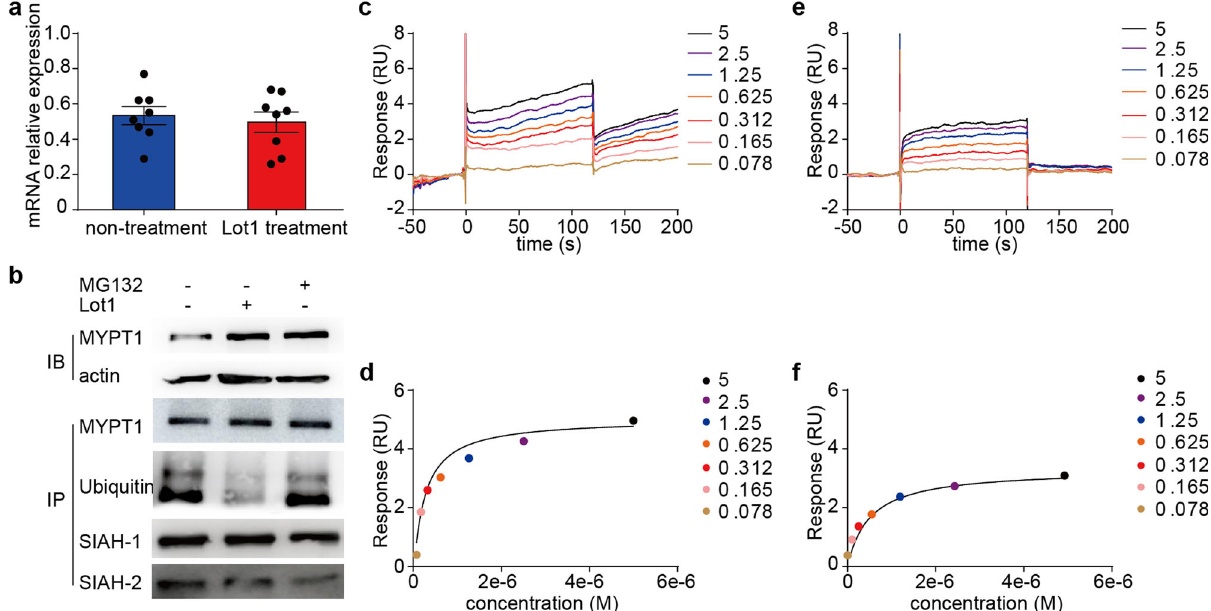
Fig. 8 Lotusine upregulated MYPT1 expression by inhibiting MYPT1 ubiquitination by binding SIAH1/2. a Mypt1 mRNA levels in A7R5 cells treated with or without lotusine were unchanged, as measured by Q-PCR ( n = 8). b , A7R5 cells were treated with MG132 (20 μ m, 4 h) and lotusine (0.5 μ m, 24 h), and the lysates were subjected to immunoprecipitation (IP) with an anti-MYPT1 antibody and immunoblotting (IB) for ubiquitinated MYPT1, SIAH2 and SIAH2 ( n = 3) in the immunoprecipitate. c-e, Representative binding sensorgrams showing the kinetics of Lot1 binding to SIAH1-GST ( c ) and SIAH2-GST ( e ). d – f , Quanti fi cation of the kinetics of Lot1 with SIAH1-GST ( d ) and SIAH2-GST ( f ). The bars indicate the mean values ± SEM; Lot1 =